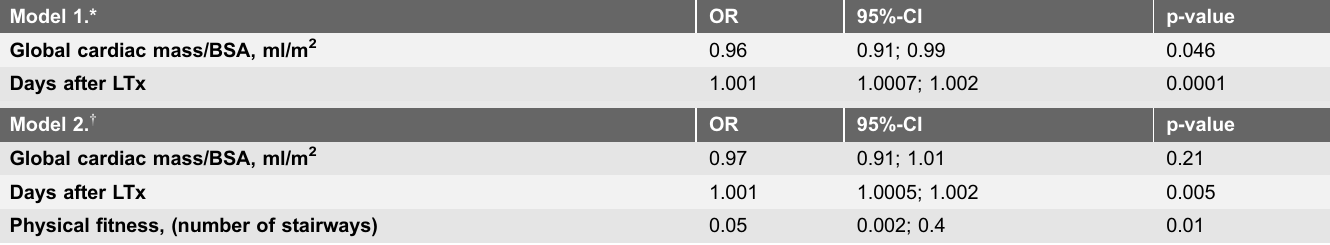
Table 3. Logistic regression model analysis for